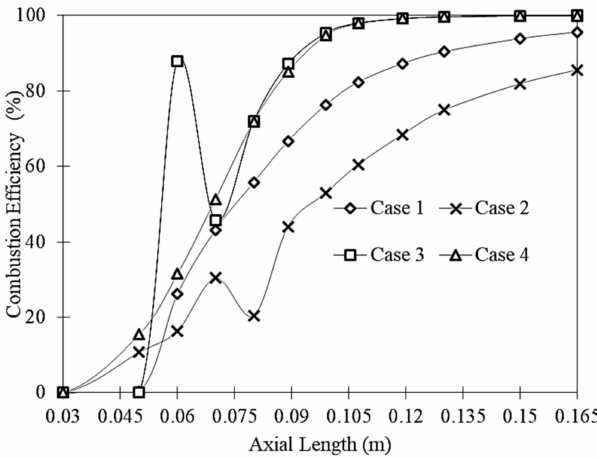
Figure 11. Combustion efficiency across the axial lengths of the combustor for different injection